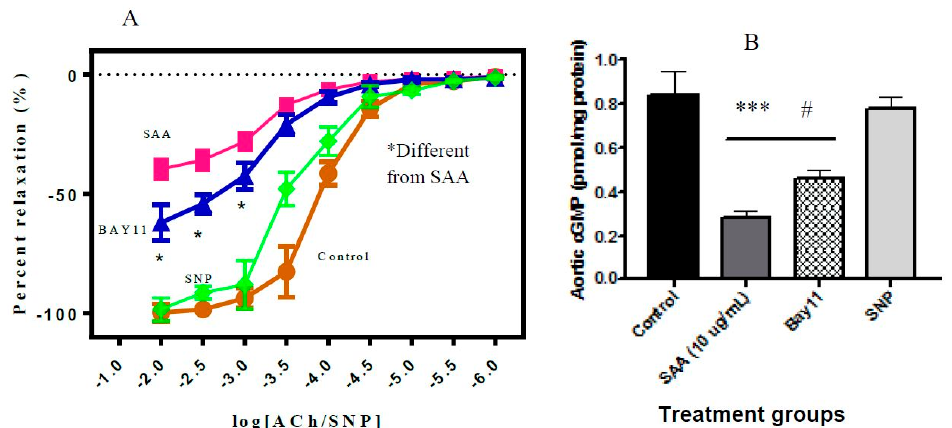
Figure 7. SAA endothelium-dependent vaso-relaxation is partially reversed by BAY11-7082. Rat aorta were isolated, cut into ring segments and mounted onto a force transducer. Rings were incubated with 10 μ g SAA protein/mL ( ), pre-treated with BAY11 ( ), or control ( ) and then pre-constricted with phenylephrine as described in the Methods section. (A) Vascular relaxation was then assessed in response to the endothelium-dependent (acetylcholine [ACh]) or endothelium-independent (sodium nitroprusside [SNP], positive control ( ) stimuli. *Different to the rings treated with SAA in the absence of BAY11-7082; P < 0.01. (B) Levels of cGMP were determined with a commercial ELISA assay. Data represent mean ± SD (SAA: n=5; BAY11: n=5; Control: n=4; SNP: n=4) independent aortic samples. Different to the control endothelium-dependent relaxation; # P <0.05. Different to rat aortic rings treated with SAA in the absence of Bay 11-7082; *** P <0.001.